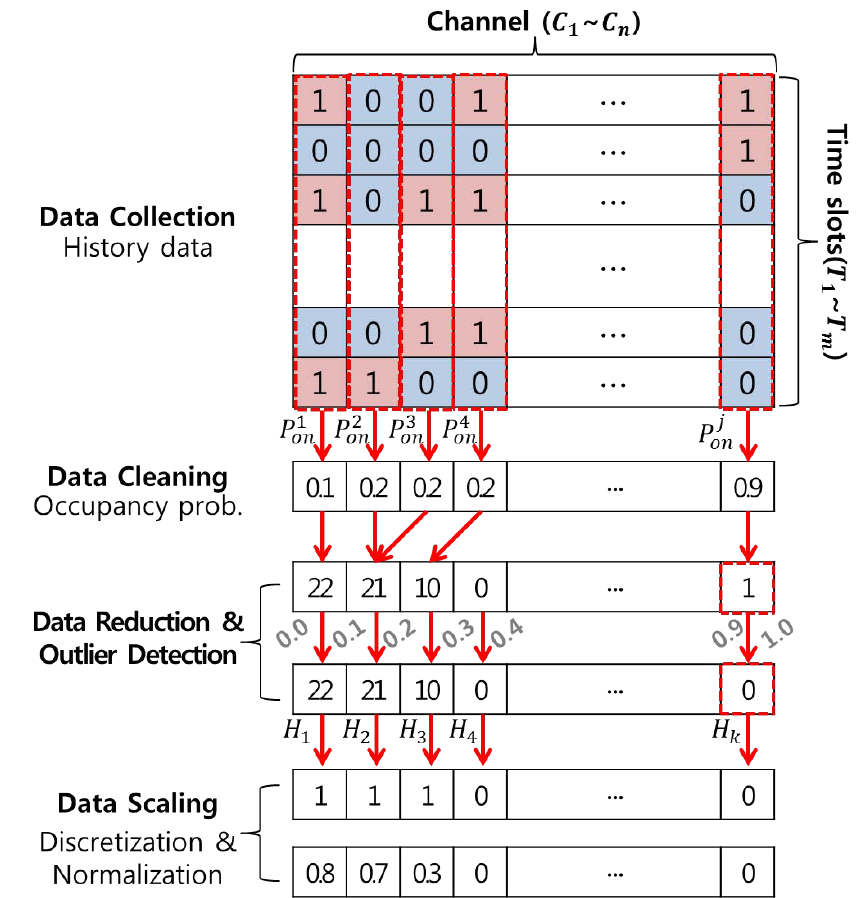
Figure 3. Data preprocessing using historic